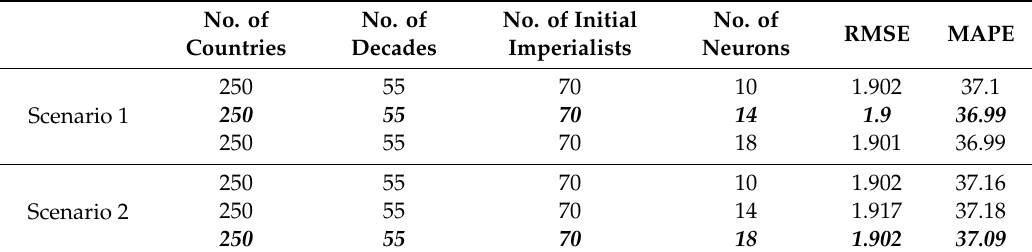
Table 6. MLP-ICA training results (mortality